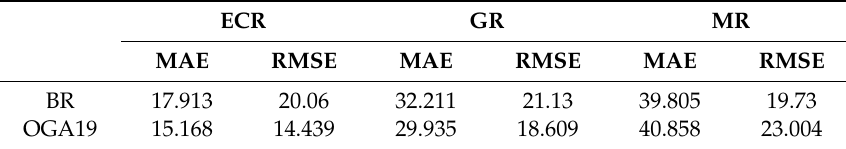
Figure 8. Validation results for the band ratio (BR) and OGA19 algorithms using the 2010 datasets of ECR ( A ), GR ( B ), and MR ( C ). Table 9. Error’s estimators for the comparison between BR and OGA19.